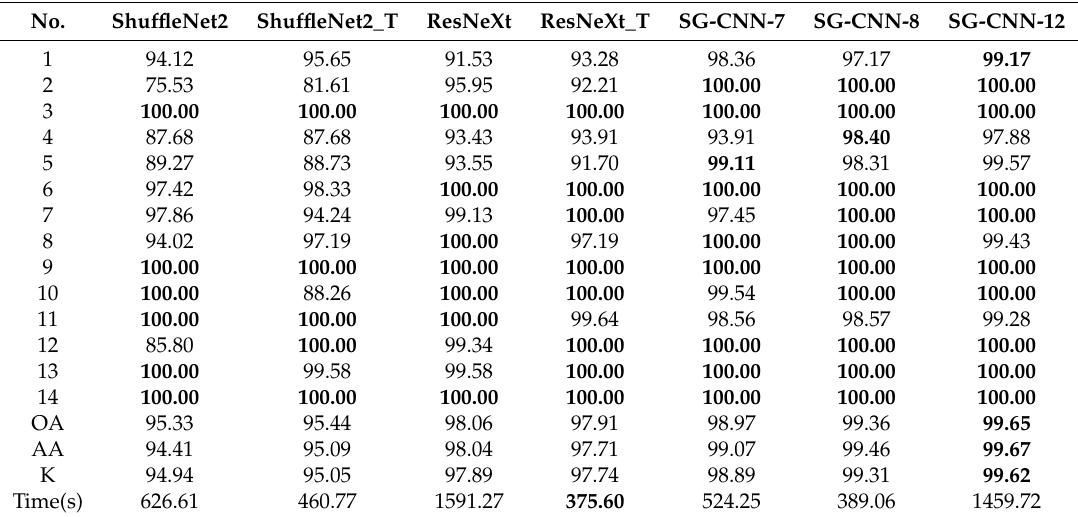
Table 4. Classification accuracy (%) and computation time of the Botswana scene. A total of 420 labeled samples (30 per class) were used for fine-tuning. The No. column refers to the corresponding class in Table 3. The best results are in bold